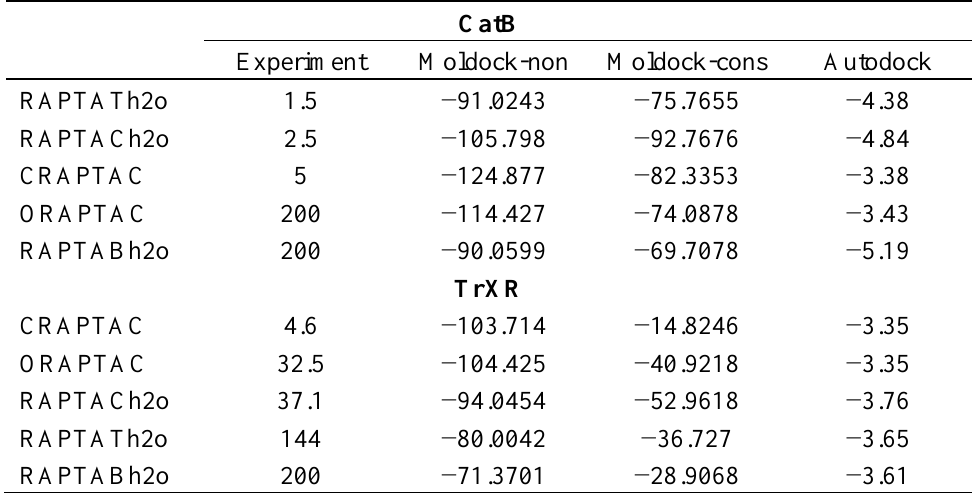
Table 8. The docking results of metallocompounds with available experimental activities.